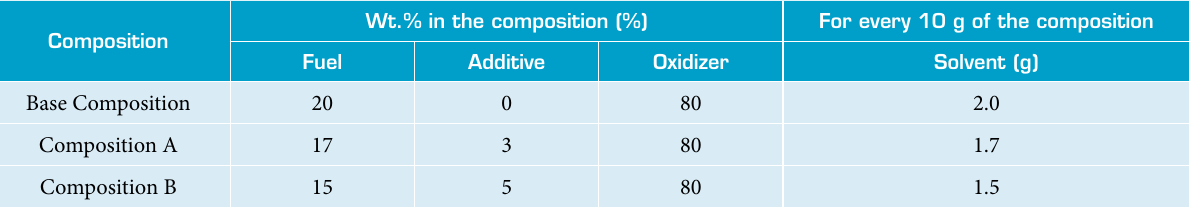
Table 2. Constituents and their wt.% in the composition.